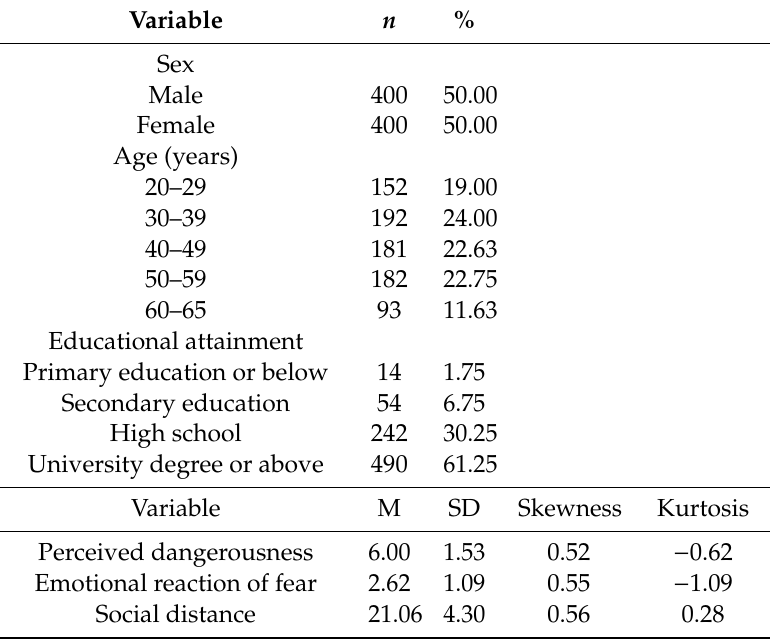
Table 1. Characteristics of the participants ( n =